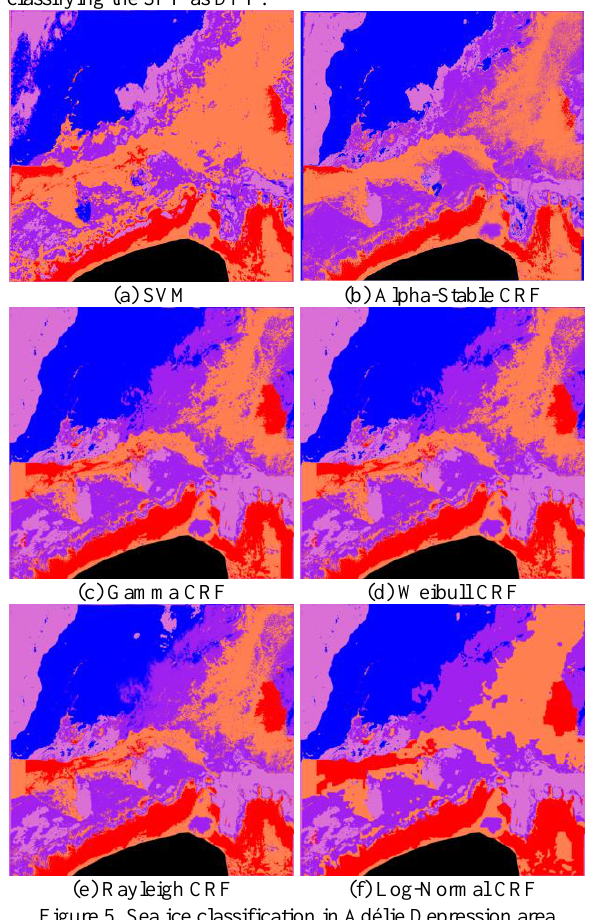
Figure 5. Sea ice classification in Adélie Depression area TABLE IV. Adélie Depression sea ice classification